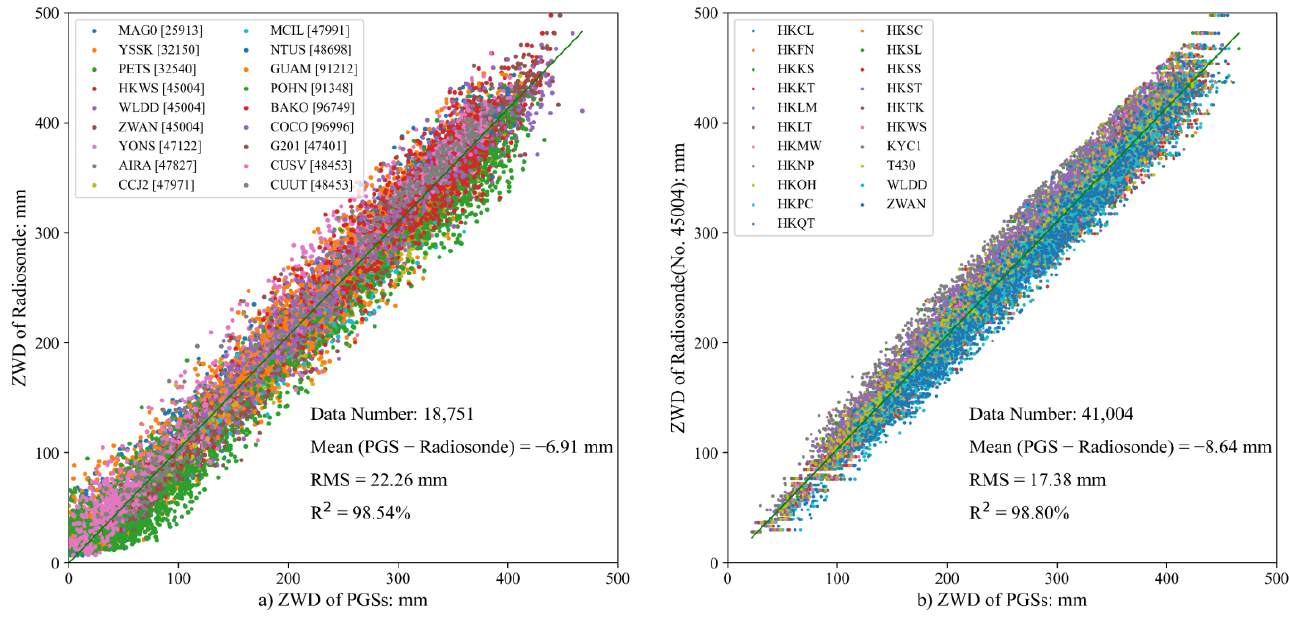
Figure 9. The ZWD comparison between the PGSs and radiosonde. Left figure is the comparison between the radiosonde and regional solutions of WSCS. The legend represents the name of the PGSs (four characters) and the ID number of radiosonde (5 digits). The right figure is the comparison between the radiosonde number of 45,004 and the PGSs of HKGSS. The legend represents the name of the PGSs.